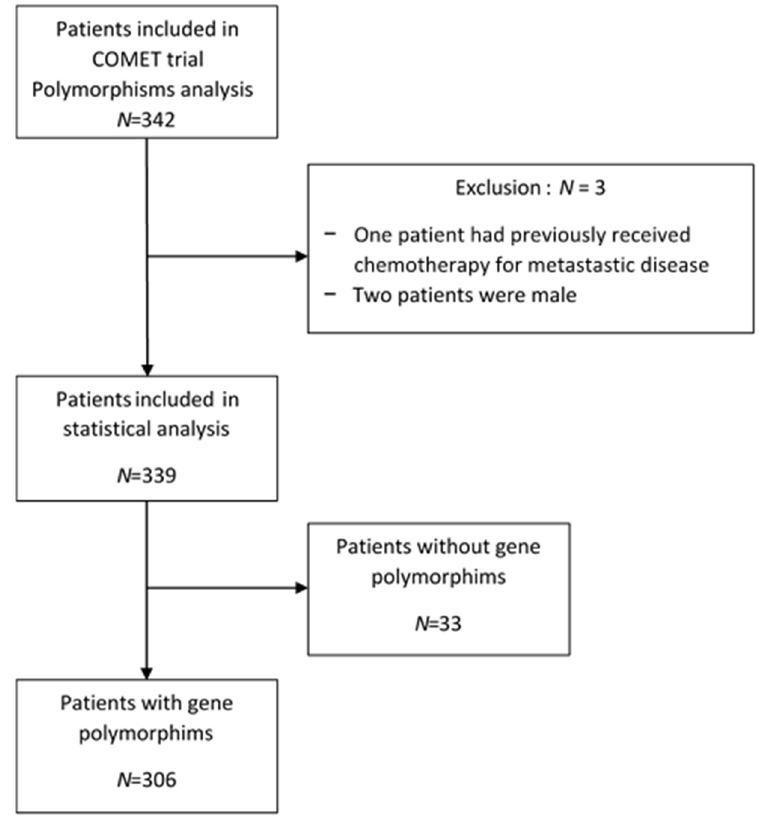
Figure 1. Flow diagram of the study participants. Table 1. Patients and tumor characteristics at baseline.